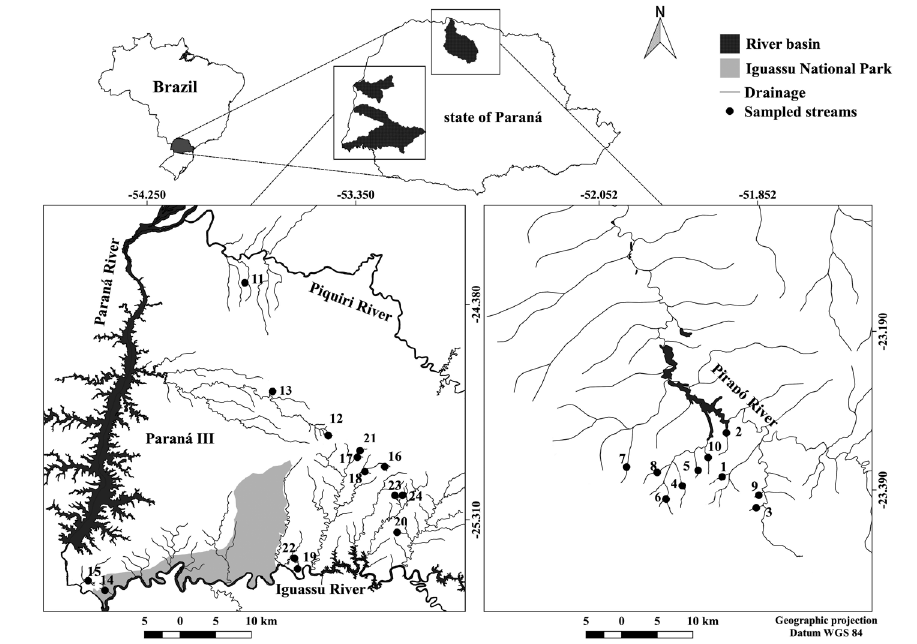
FIGURE 1 | Location of the sampling sites in the 24 streams in the state of Paraná, Brazil. Codes and names of streams in S1